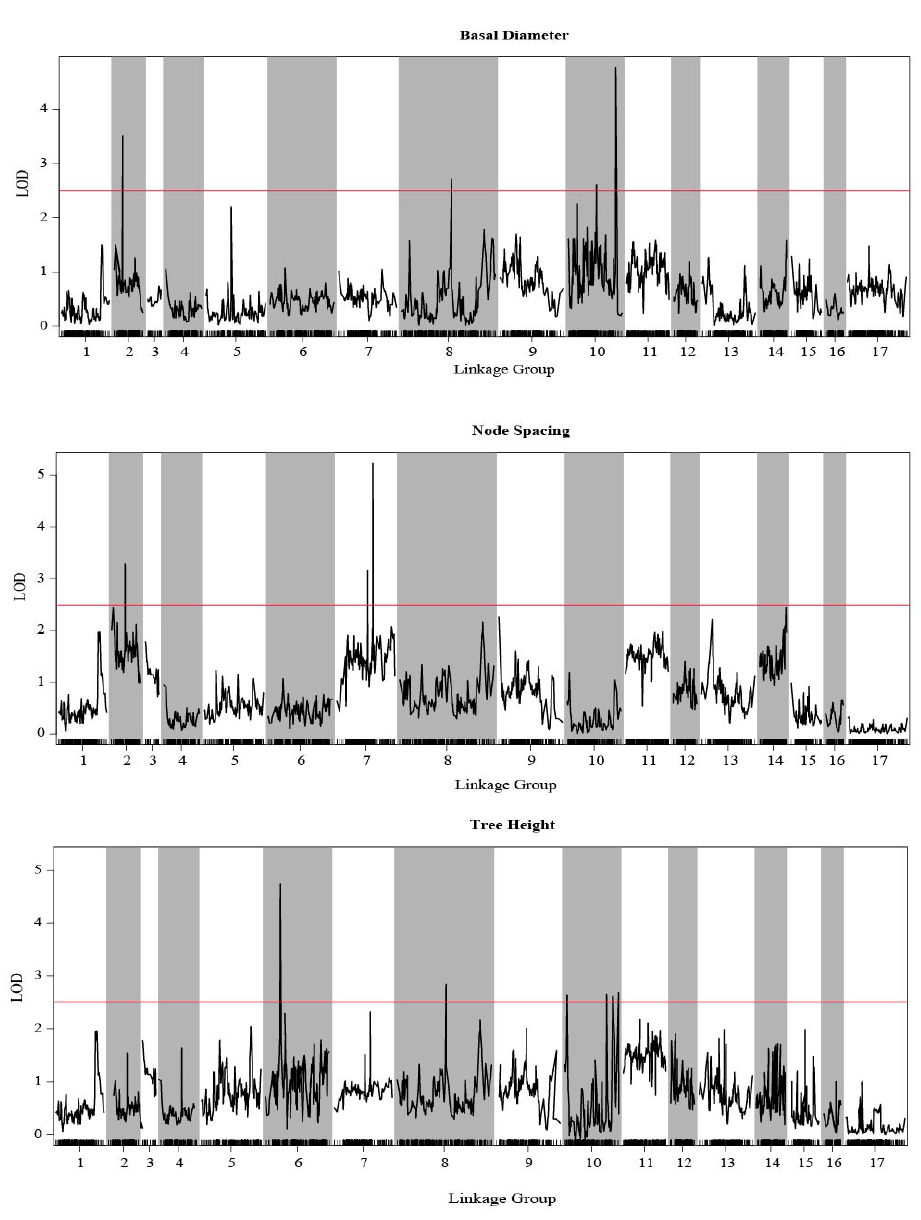
Figure 5. Growth trait-associated QTLs in E. ulmoides among all linkage groups. The threshold was set to LOD = 2.5. Table 2. QTLs detected for node spacing using integrated genetic